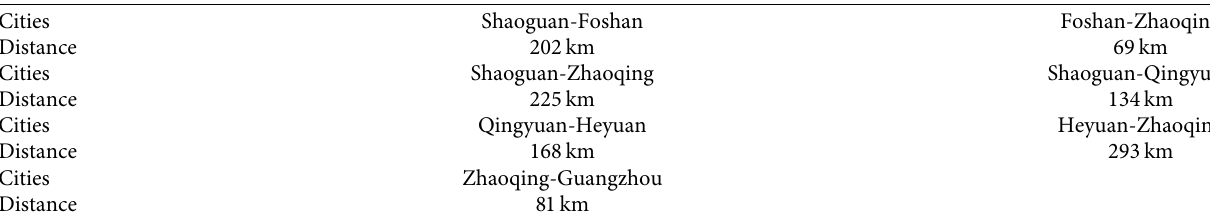
Table 2: Distance between cities.